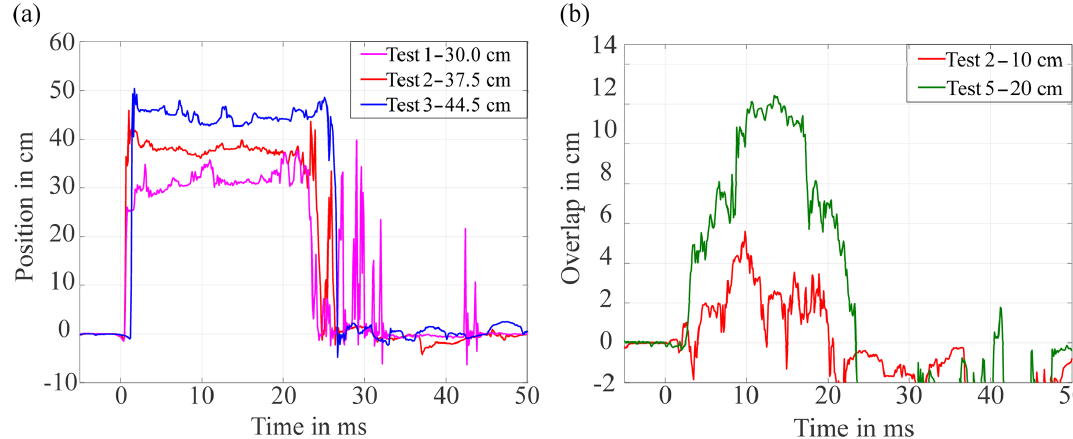
Figure 7. Results from pendulum tests: (a) different impact position (with 10cm impactor) and (b) different overlap (at impact position